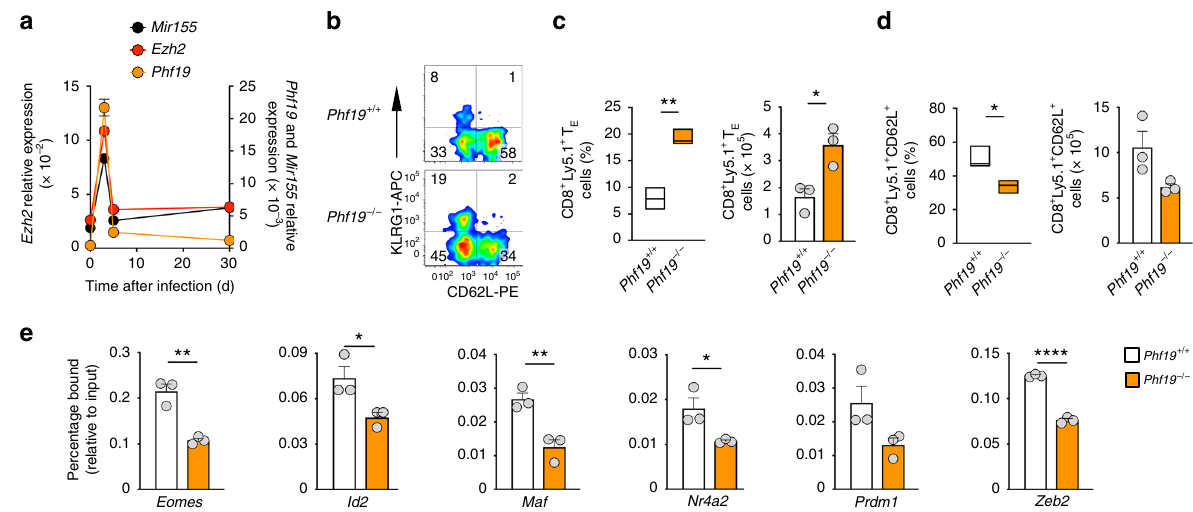
Fig. 5 Phf19 restricts CD8 + T cell terminal differentiation. a Quantitative RT-PCR of Mir155 , Ezh2 , and Phf19 after transfer of 10 5 pmel-1 CD8 + Ly5.1 + T cells into wild-type mice in conjunction with gp100-VV assessed at the indicated points. Ezh2 and Phf19 levels are relative to Rpl13 , Mir155 levels are relative to U6 . b Flow cytometry of splenic live CD8 + Ly5.1 + T cells 5 days after transfer of 3 × 10 5 naïve pmel-1 CD8 + Ly5.1 + Phf19 + / + or Phf19 − / − T cells into